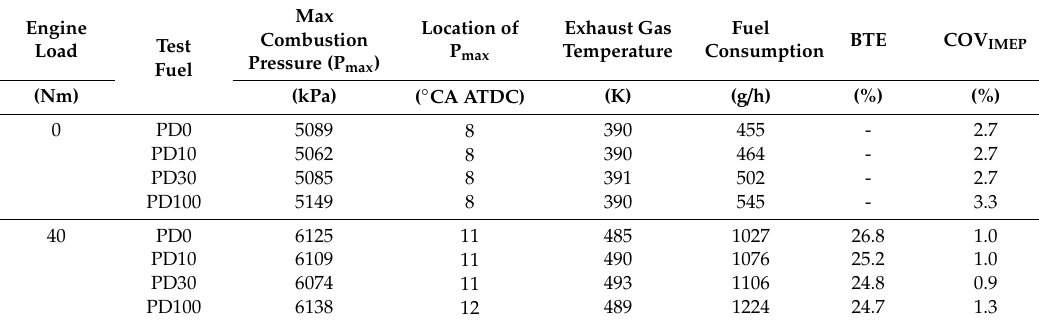
Figure 4. Combustion pressure and heat release rate of ( a ) 0 Nm, and ( b ) 40 Nm; combustion pressure rise rate of ( c ) 0 Nm, and ( d ) 40 Nm. Table 5. Combustion characteristic under test conditions.